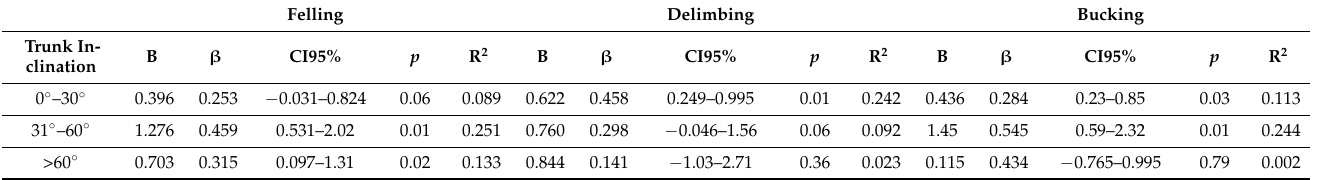
Table 5. Linear regression model: trunk inclination classifications as predictive variables associated with ACC in the total sample ( n = 40) for the three tasks of felling, delimbing, and bucking. Felling Delimbing Bucking